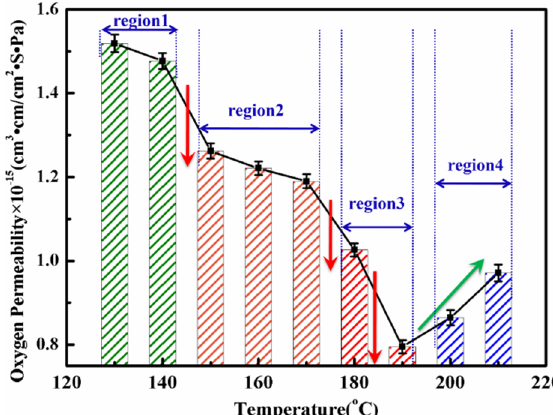
Figure 3. P o 2 of coated PET film cured at different temperatures.